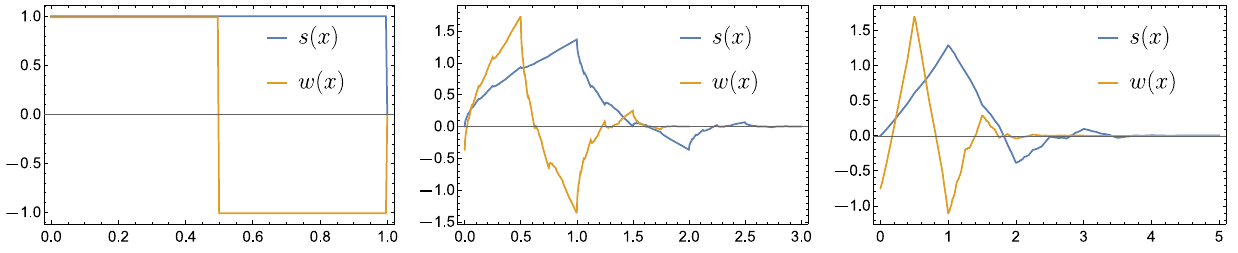
FIG. 2. From left to right: scaling s ( x ) and wavelet w ( x ) functions for the db K wavelet with index K = 1, 2, 3; db1 wavelet is identical to Haar wavelet. The support of these functions is [0, 2 K − 1]. The s ( x ) and w ( x ) for db3 wavelet have continuous first